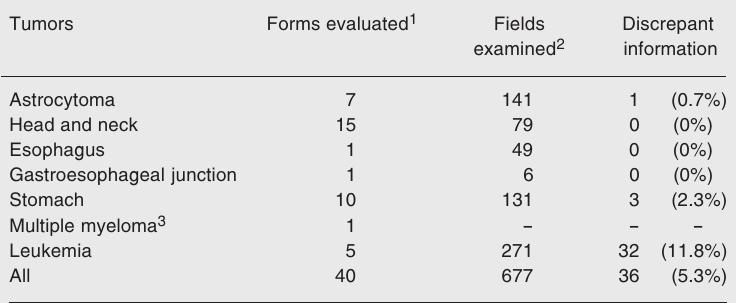
Table 5. Evaluation of data entry consistency in the follow-up form.